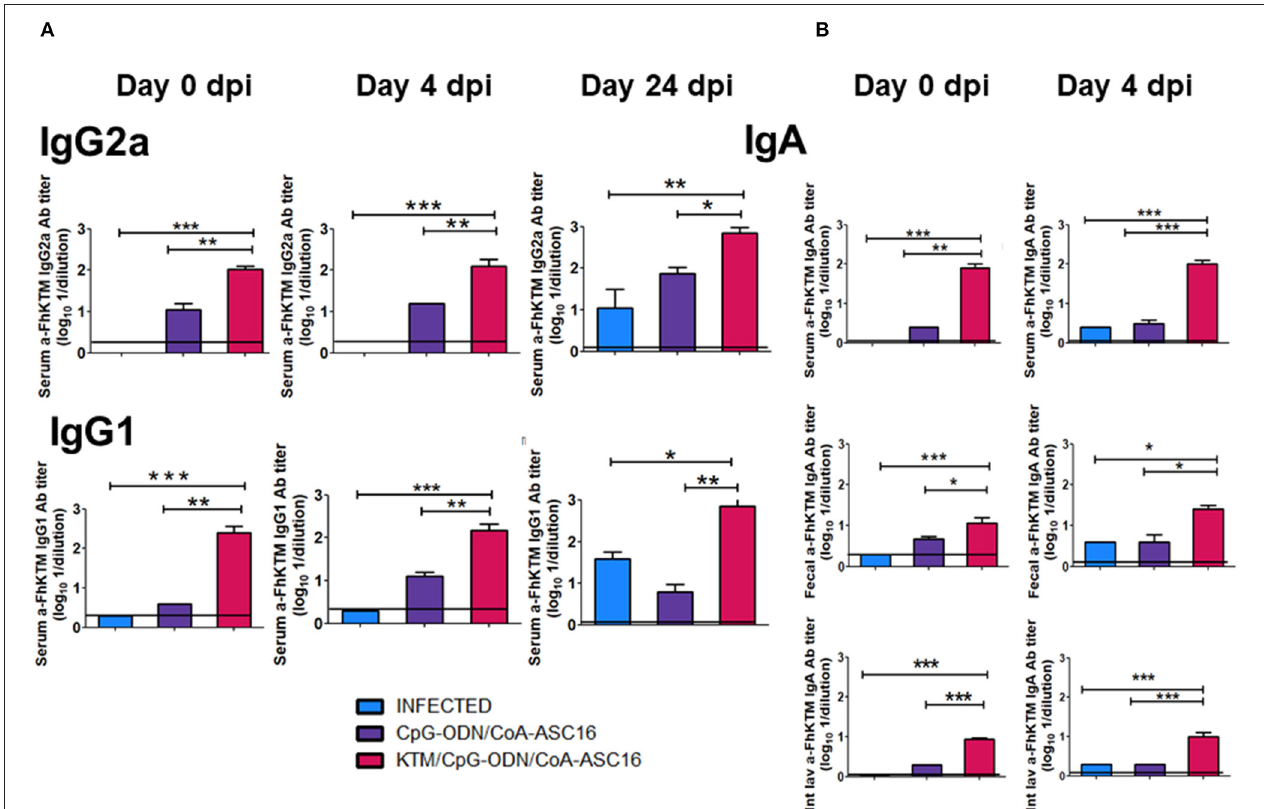
FIGURE 3 | FhKTM-specific IgG antibodies detection. (A) IgG1 and IgG2a subclass antibodies in the sera of the immunized mice by enzyme-linked immunosorbent assay (ELISA). Serum samples were collected from the mice by retro-orbital bleeding at 0, 4, and 24 dpi. Humoral immune responses were analyzed. (B) IgA titles were detected in the acute infection on days 0 and 4 in sera, feces, and intestinal lavage. Results have been expressed as the mean of OD 450 ± SD values ( n = 15) and are representative of at least three independent experiments. The data were analyzed by one-way ANOVA and Tukey’s multiple comparison tests* p < 0.05; ** p < 0.01; *** p <